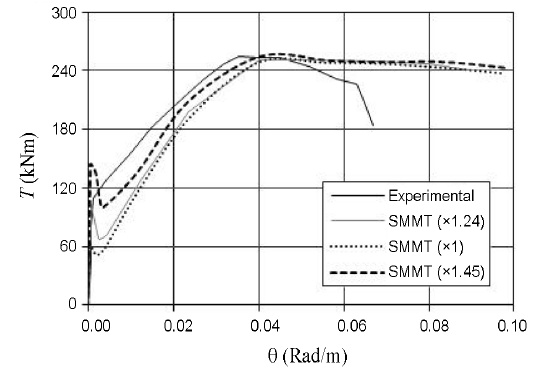
Fig. 3. T – θ curves for Beam